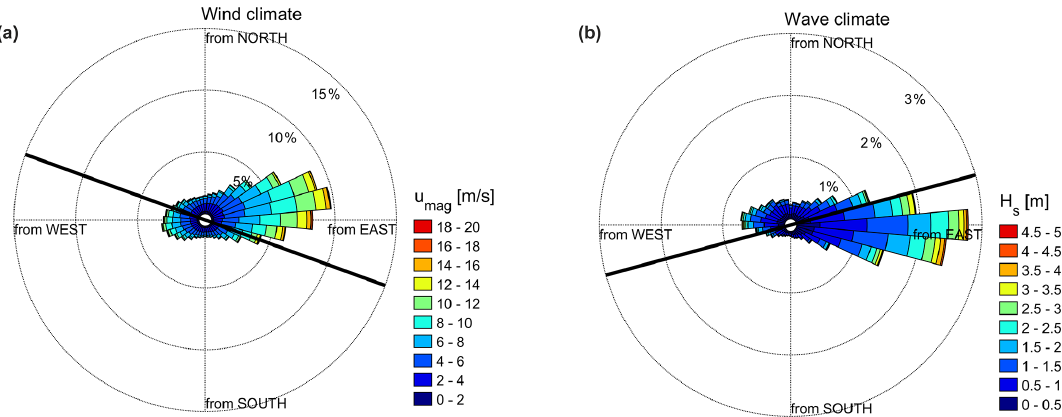
Figure 2. Wind (left; a ) and wave (right; b ) climate at the single ERA5 output point of 72 ◦ N, 147 ◦ W for the time period 1979–2019 (see Fig. 1 for the location). In panel (a) the black line depicts the overall coastline orientation of 110 ◦ N, and in panel (b) it is the mean wave direction of 75 ◦